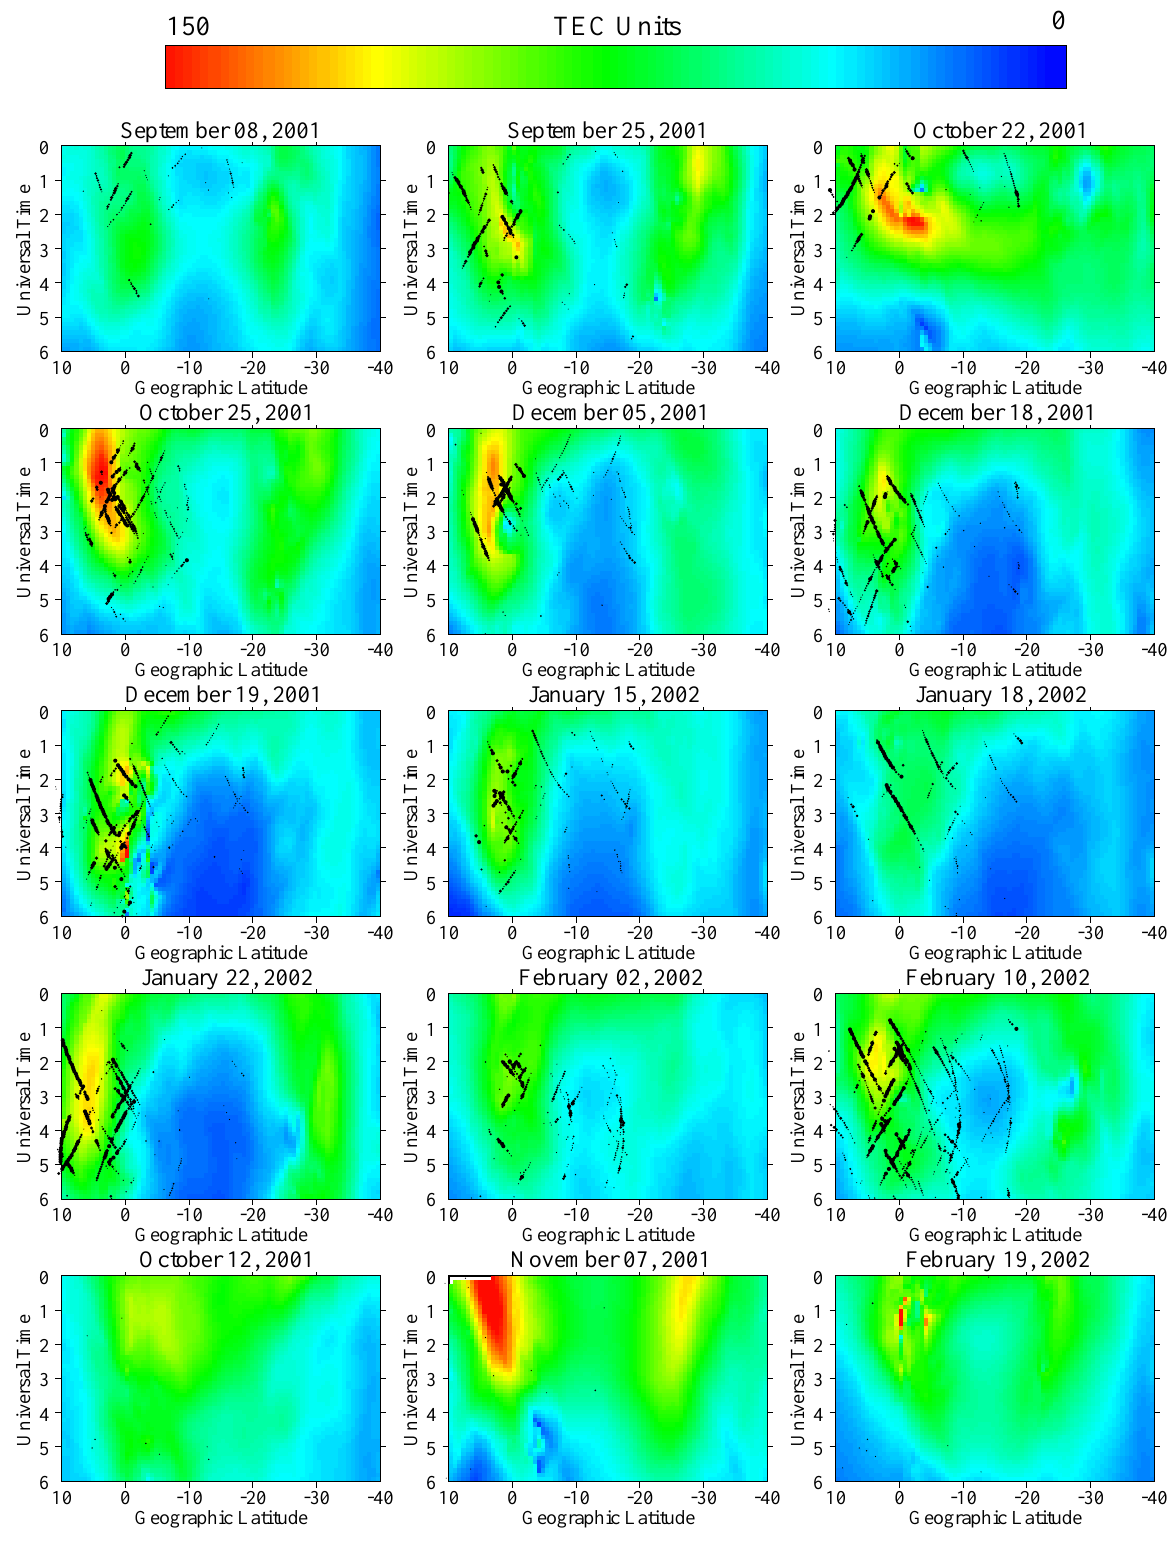
Fig. 7. Absolute TEC distributions for 15 case study events observed during the equinox and December solstice seasons. The first 12 cases correspond to days of GPS scintillations and the last 3 (the lower row) are for days with no scintillations. The black traces indicate the location, time and intensity of the GPS